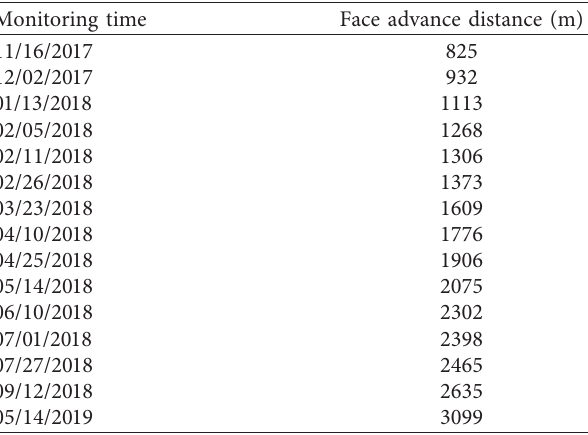
Table 2: Monitoring times for Line N and the corresponding face advance